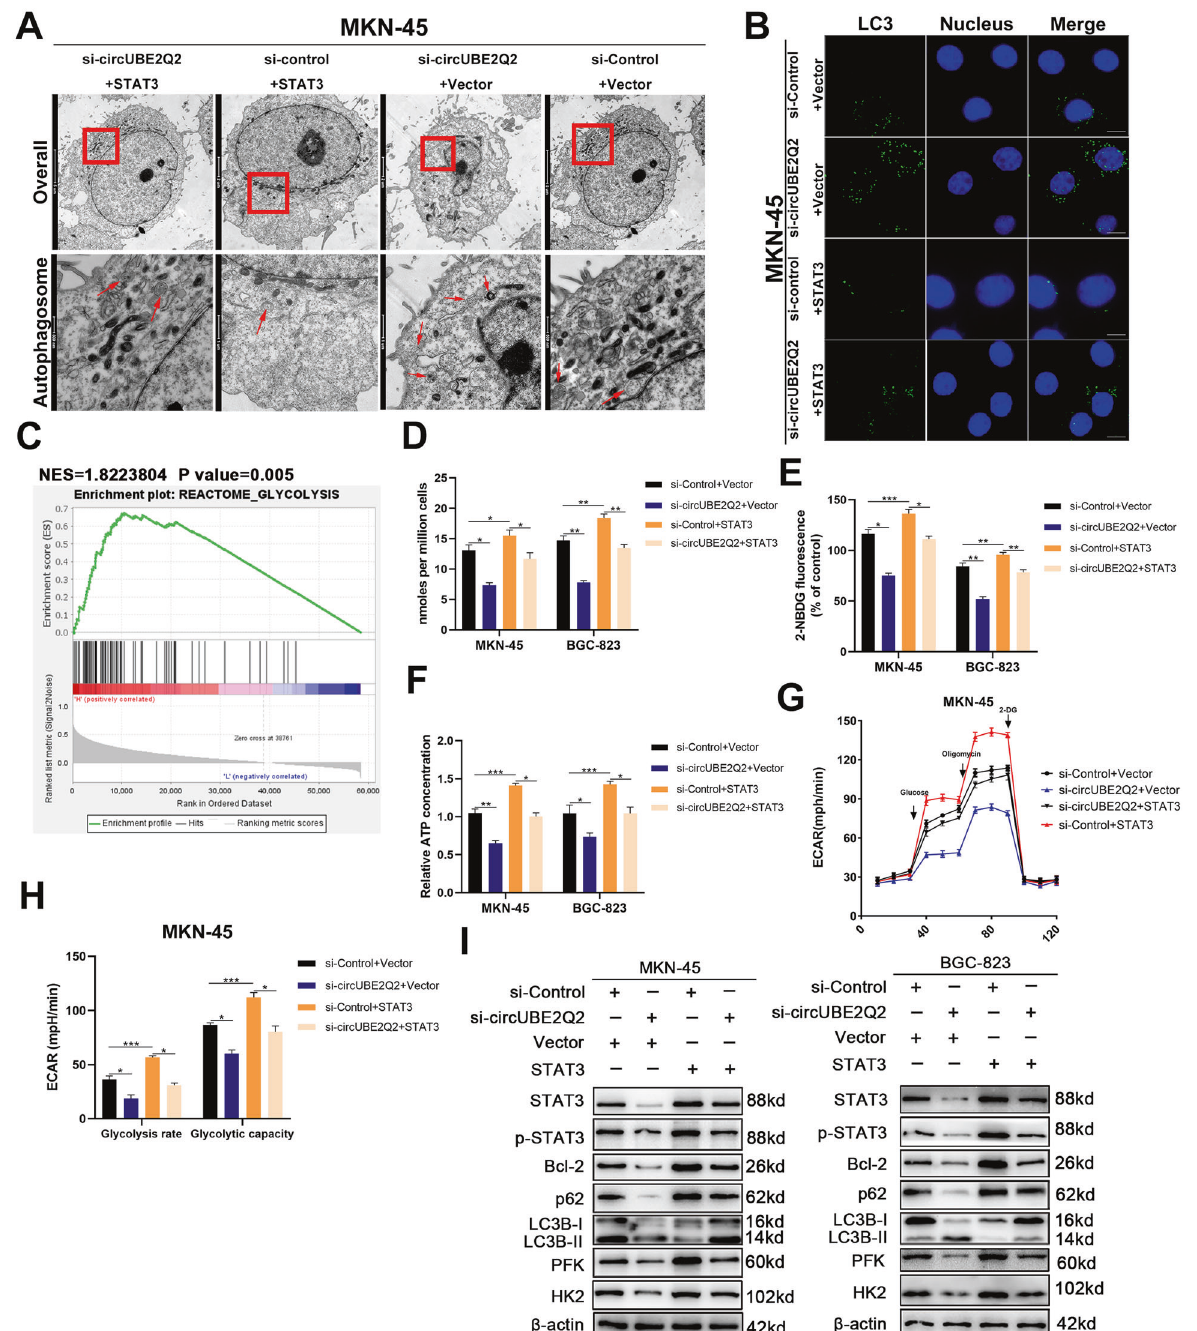
Fig. 6 CircUBE2Q2 sponges miR-370-3p to inhibit autophagy and promote glycolysis. A The number of autophagosomes observed in MKN-45 cell lines cotransfected with circUBE2Q2-speci fi c siRNA or STAT3 plamids using transmission electron microscopy (TEM). B The role of circUBE2Q2/ STAT3 on autophagy using anti-LC3 via IF in MKN-45 cells, scale bar = 20 μ m. C Gene set enrichment analysis (GSEA) identi fi ed a signi fi cant positive correlation between STAT3 and the glycolysis pathway. D – F Lactate production, glucose uptake, and ATP production detected in GC cells. G , H Extracellular acidi fi cation rate (ECAR) measured in treated MKN-45 cells. I Protein levels of STAT3, p-STAT3, Bcl-2, p62, LC3B, PFK, and HK2 in treated MKN-45 and BGC-823 cell lines detected by western blottings. Data are expressed as the mean ± SD. * p < 0.05, ** p < 0.01, *** p < expression, whereas further STAT3 overexpression reversed We detected the expression levels of STAT3, p-STAT3 these effects (Fig. 6I). Furthermore, simultaneous transfection (phospho Y705), Bcl-2, LC3, P62, and hexokinase-2 (HK2) and of STAT3 plasmid reversed the downregulated expression of phosphofructokinase (PFK) in GC cells through western glycolytic proteins, PFK and HK2, which was caused by blottings. Knocking down circUBE2Q2 could promote the circUBE2Q2 silencing (Fig. 6I). expression of autophagy marker LC3 and inhibit P62 and Bcl-2